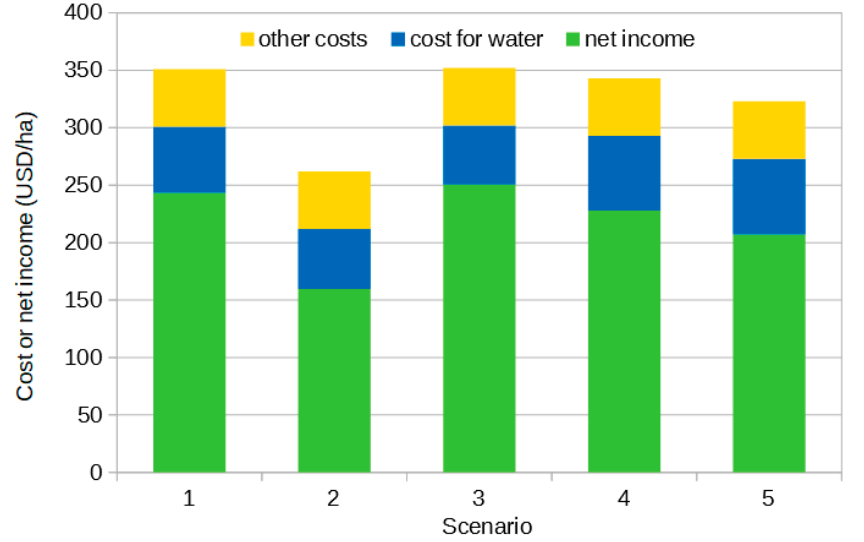
Figure 7. Comparison of costs and net income among the scenarios.